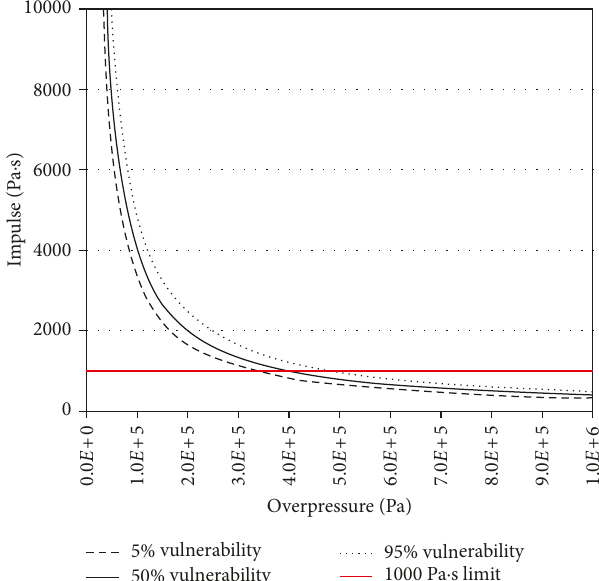
Figure 4: Vulnerability of humans (head impact).